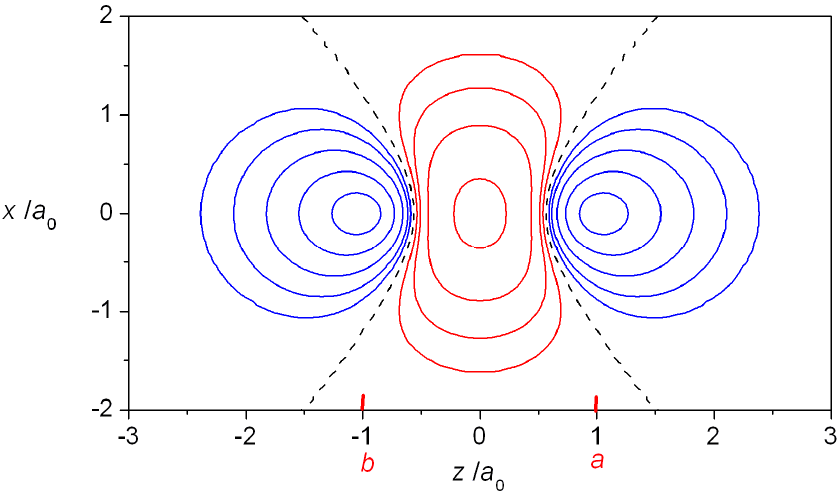
Figure 5. Contour map of the interference density ρ I in the xz plane of H 2 + at R = 2.0 a 0 and ζ = 1.239 (where z is the internuclear coordinate). The positive / negative contours ( ρ I + / ρ I − ) in red / blue are ± 0.002, ± 0.004, ± 0.008, ± 0.016, and − 0.032. The dashed lines represent zero ρ I contours. The nuclei ( a , b ) are at (0, ± 1.0 a 0 ).